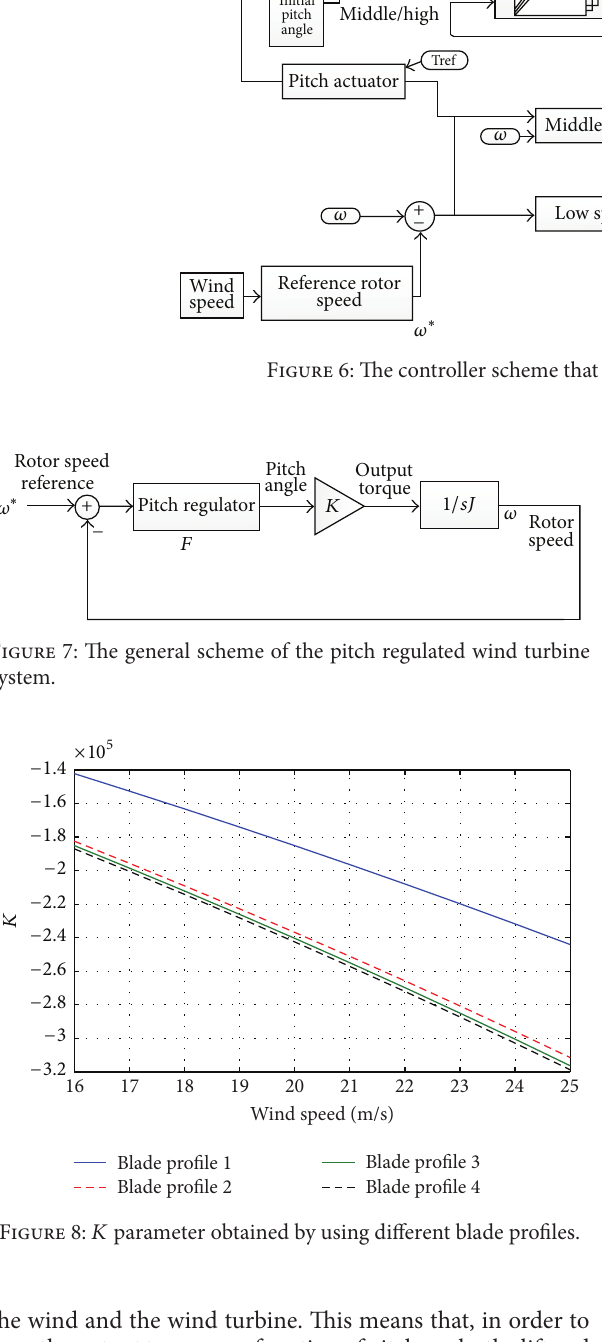
the wind and the wind turbine. This means that, in order to have the output torque as a function of pitch angle, the lift and drag coefficient should be a function of it as well. Equation (6) show that 𝑐 𝐿 and 𝑐 𝐷 are functions of the angle of attack. The angle of attack is expressed as 𝛼 = 𝜙 − 𝛽 which means that 𝛼 and therefore 𝑐 𝐿 and 𝑐 𝐷 are functions of the pitch